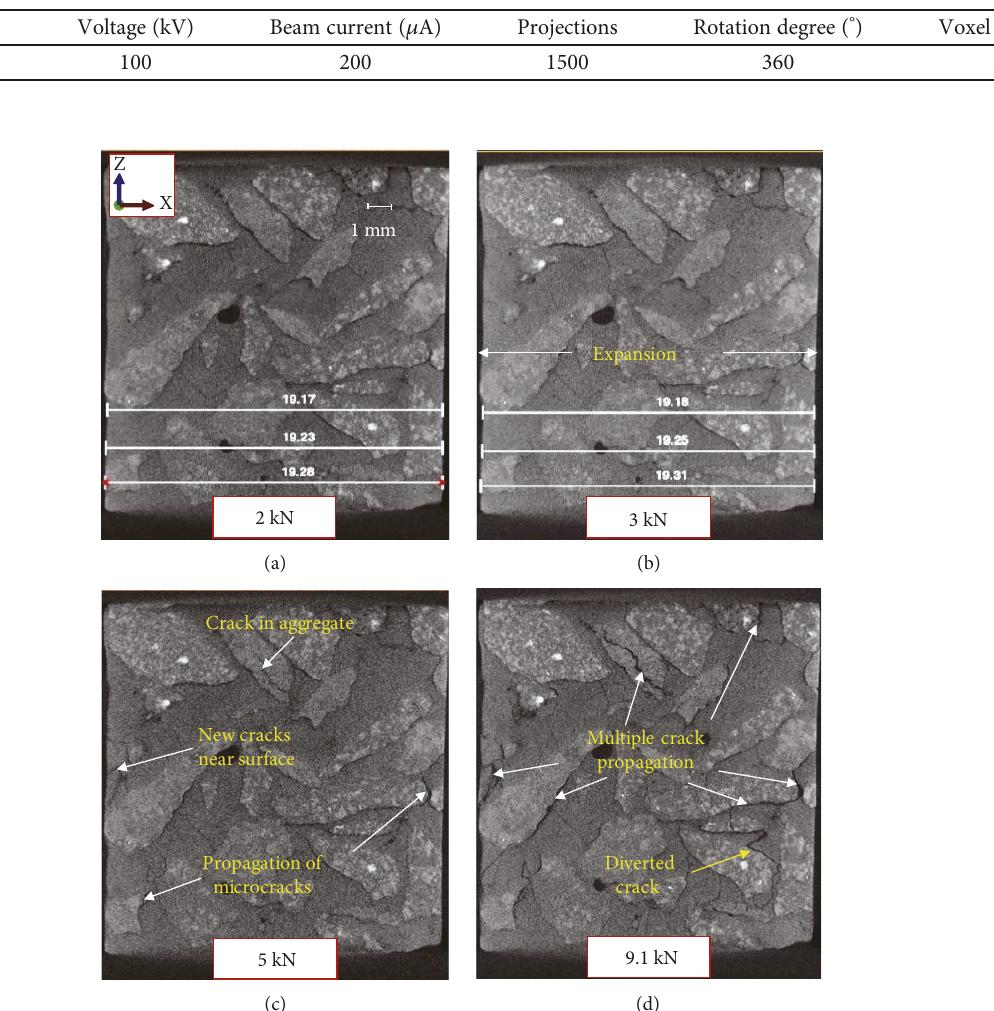
Figure 2: Propagation of internal microcracks in a CT slice as the load